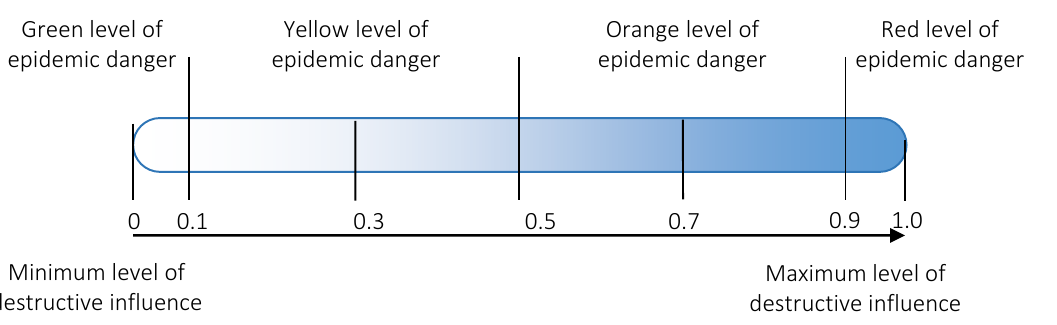
Figure 2. Application of the thermometer principle to determine the correction factors of modeling compared the trend values of varia- ble parameters of the model (conditionally cor-